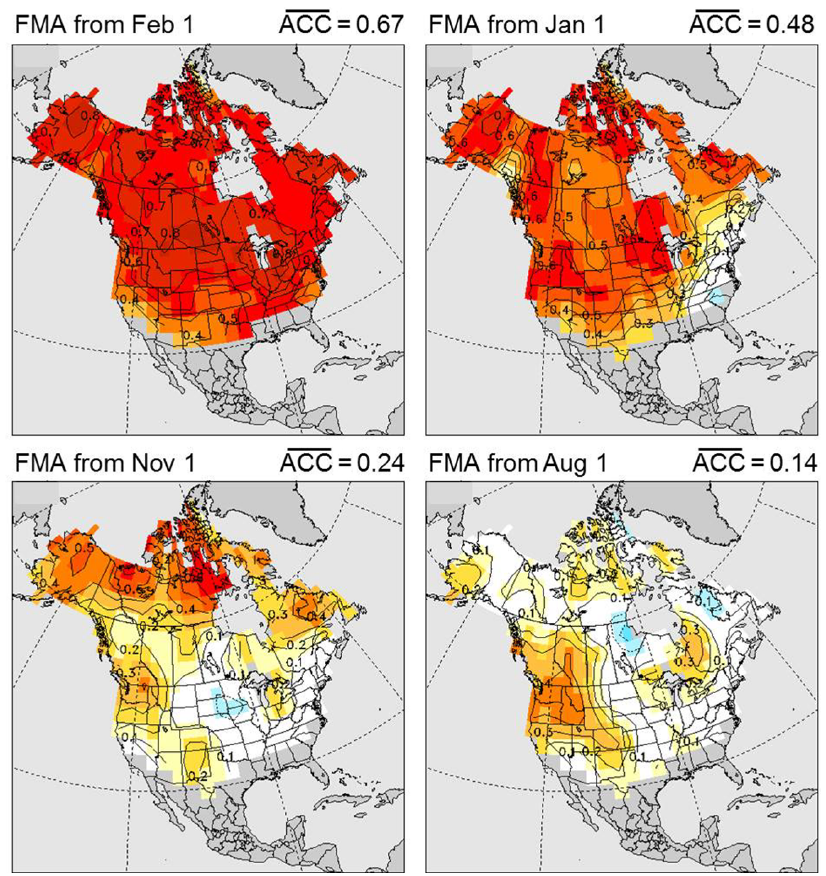
Figure 11. Anomaly correlation coefficient (ACC) skill for February–April (FMA) SWE of 1981–2010 CanSIPS hindcasts initialized at the start of February and the preceding January, November, and August (lead times of 0, 1, 3, and 6 months, respectively). The Blended-5 dataset of Mudryk et al. (2015) is used for observational verification. The contour interval is 0.1, and the overbars denote spatial averages of ACC over areas of North America having seasonal snow cover.